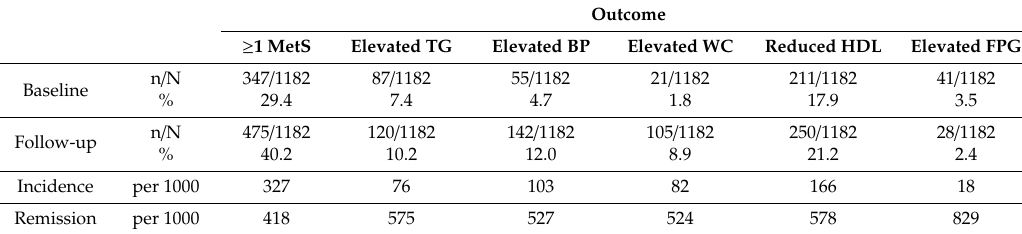
Table 2. Baseline prevalence, follow-up prevalence, incidence rate, and remission rate of MetS components, based on Harmonized Criteria.